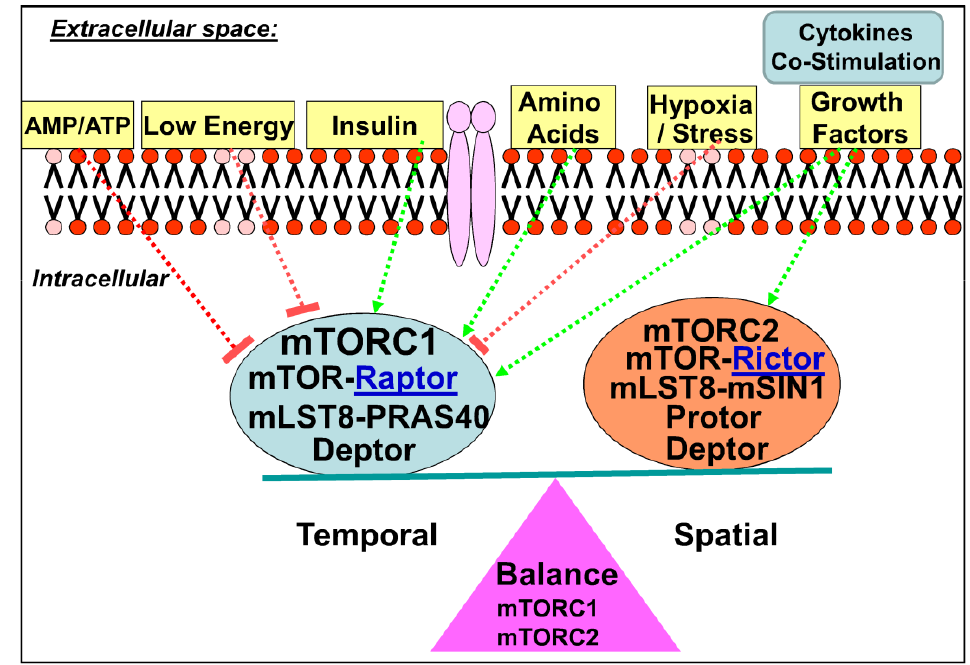
Figure 2. mTORC1 and mTORC2 integrate signals from diverse extracellular inputs. mTOR complexes integrate signals from diverse environmental cues. mTOR forms at least two complexes with the newly identified exclusive as well as common binding